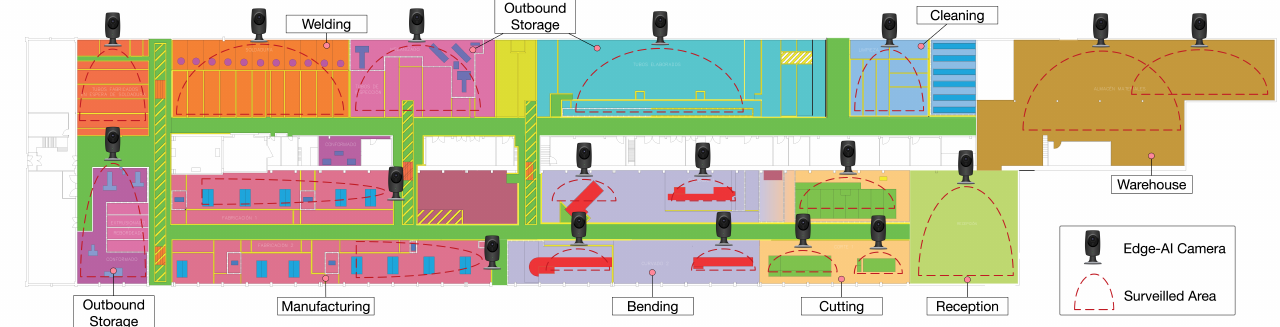
Figure 9. Floor map of the smart